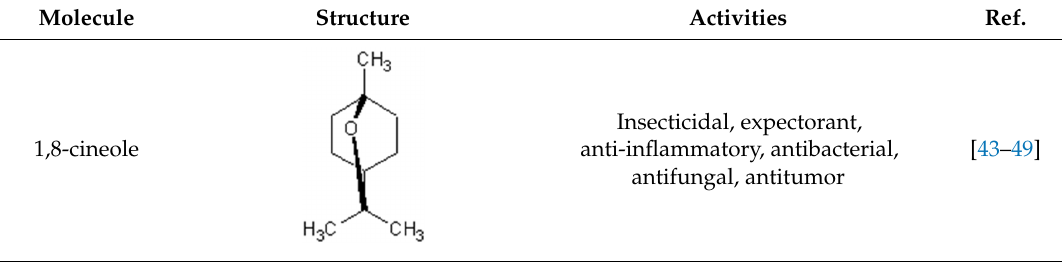
Table 1. Structure and biological activities of major monoterpenes of Artemisia annua essential oil. Molecule Structure